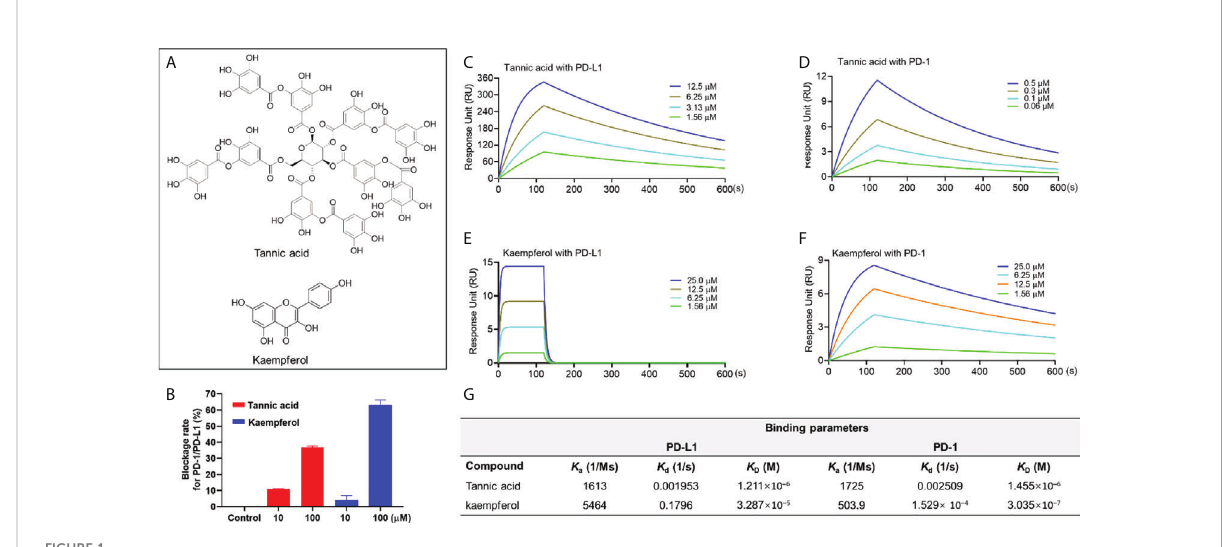
FIGURE 1 Chemical structure of TA and kaempferol (A) . Blockade rate of TA and kaempferol (at 10 and 100 m M) on the PD-1/PD-L1 interaction determined by the pair ELISA assay (B) . Binding pro fi le of natural compounds at various concentrations with PD-1 and PD-L1 proteins characterized by the SPR measurements. Sensograms of TA with PD-L1 (C) or PD-1 (D) protein at 1.56-12.5 m M and 0.06-0.5 m M, respectively. Sensograms of kaempferol with PD-L1 (E) and PD-1 (F) protein at 1.56-25 m M. Summarized binding parameters including Ka, Kd, and K D between test compounds and PD-L1 and PD-1 proteins (G)